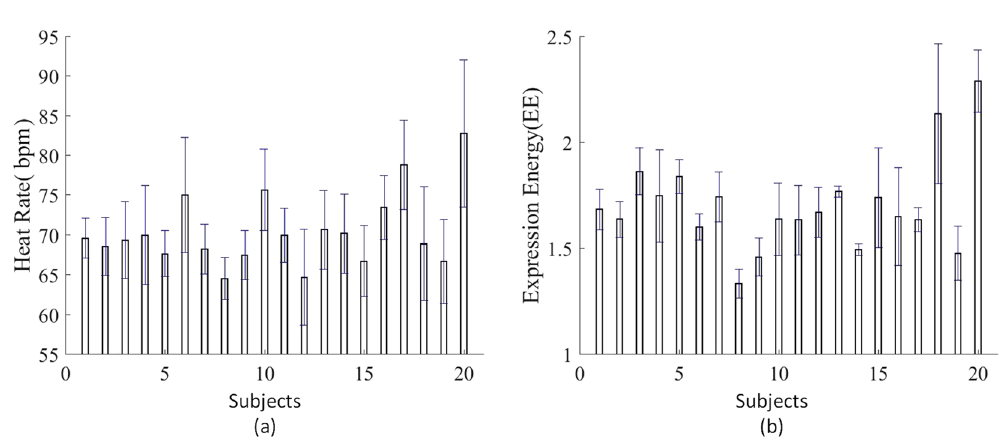
Figure 3. Individual difference in HRs and EEs. Each bar represents the average for the 20 subjects for HRs and EEs. Error bars represent standard deviations